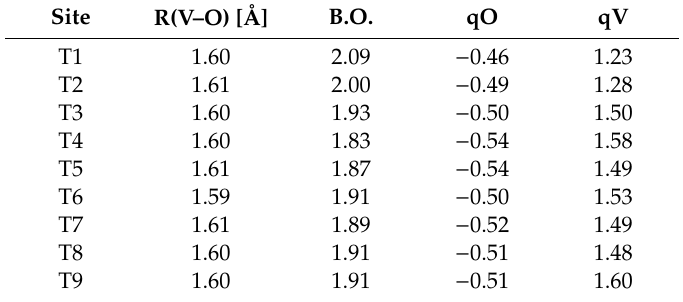
Table 3. Structural parameters (R—distance, B. O. Mayer bond order indices, q—Mulliken charges) of the V = O group introduced to di ff erent crystallographic positions in BEA zeolite.